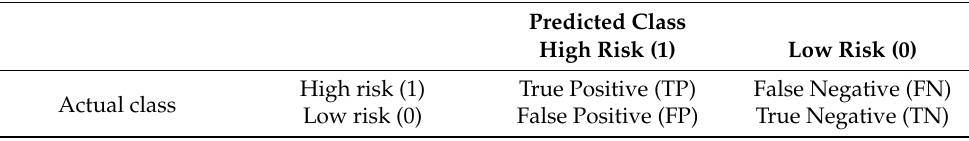
Table 6. Confusion